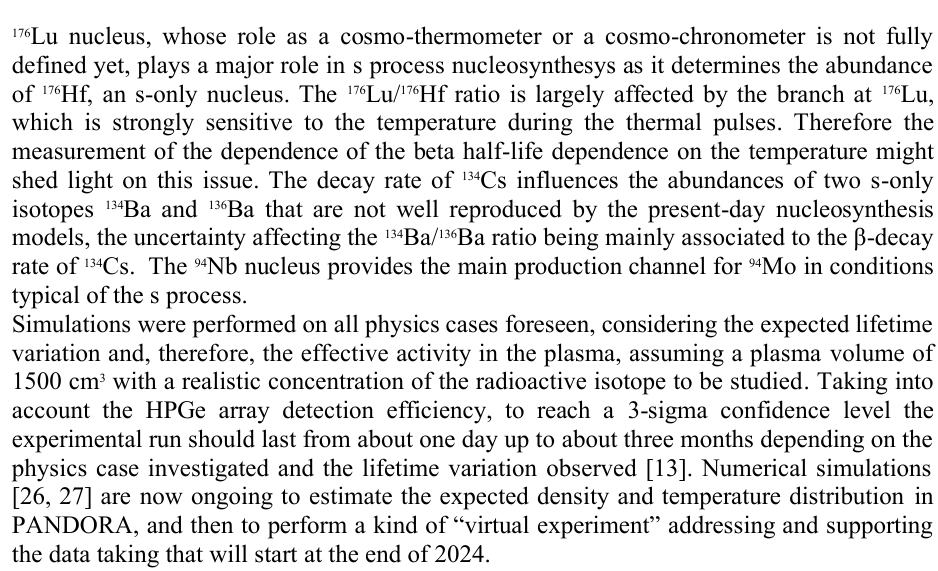
Fig. 4 – Theoretical prediction of stellar half-life to terrestrial half-life ratio for 176 Lu nucleus as a function of plasma temperature expressed in T 6 [10 6 K] (Energy [keV]). Calculations were performed at plasma densities of 10 12 cm −3